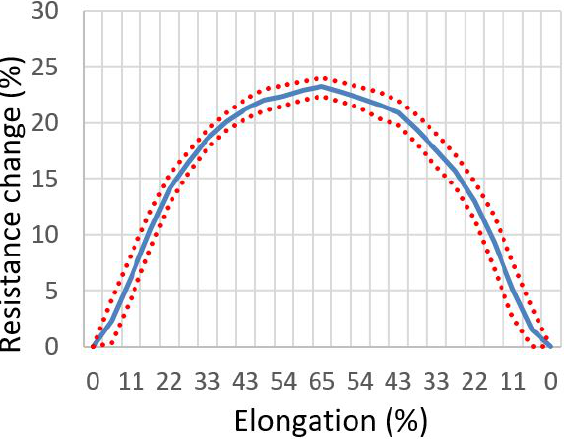
Figure 6. Measured resistance variation at different strain points. Up and down strain cycle and repeatability (dot line) are